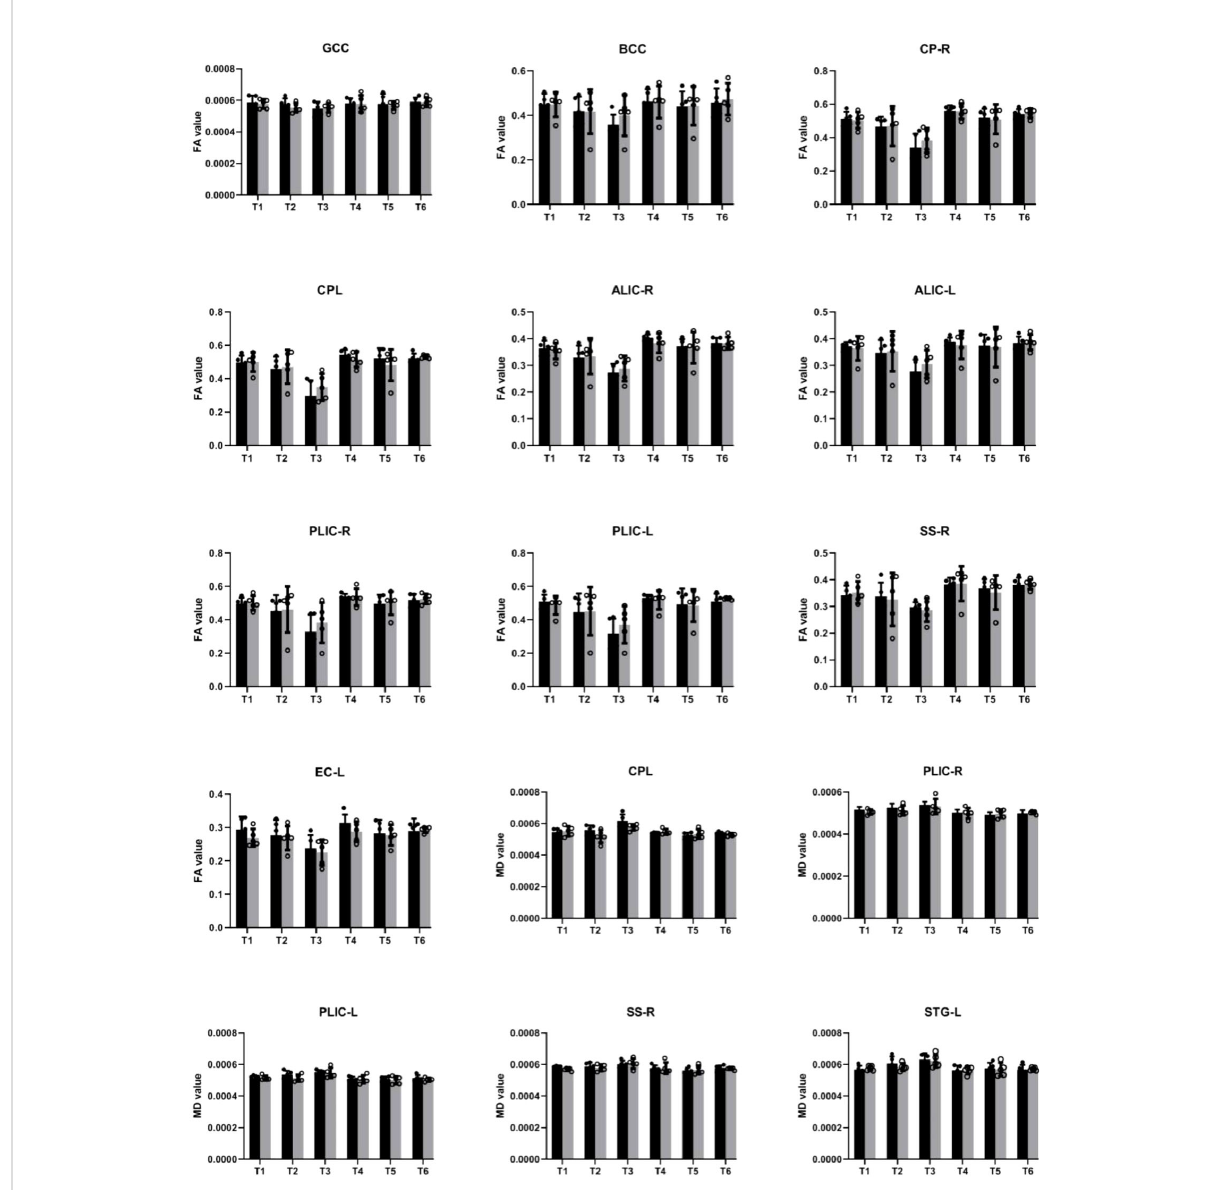
FIGURE 5 Illustration of signi fi cant alterations of FA and MD across time in cART- and cART+ groups. Bars, mean ± SE. Black, SIV-mac239 infected macaques without treatment; Gray, SIV-mac239 infected macaques with regular treatment. Note: T1 the baseline; T2, 10 days post virus inoculation; T3, the 4th week post virus inoculation; T4, the 12th week post virus inoculation; T5, the 24th week post virus inoculation; T6, the 36th week post virus inoculation. GCC, Genu of Corpus Callosum; BCC, Body of Corpus Callosum; CP-R, Cerebral Peduncle - Right; CP-L, Cerebral Peduncle - Left; ALIC-R, Anterior Limb of the Internal Capsule – Right; ALIC-L, Anterior Limb of the Internal Capsule – Left; PLIC-R, Posterior Limb of the Internal Capsule – Right; PLIC-L, Posterior Limb of the Internal Capsule – Left; SS-R, Sagittal Striatum - Right; EC-L, External Capsule - Left; STG-L, Superior Temporal Gyrus –